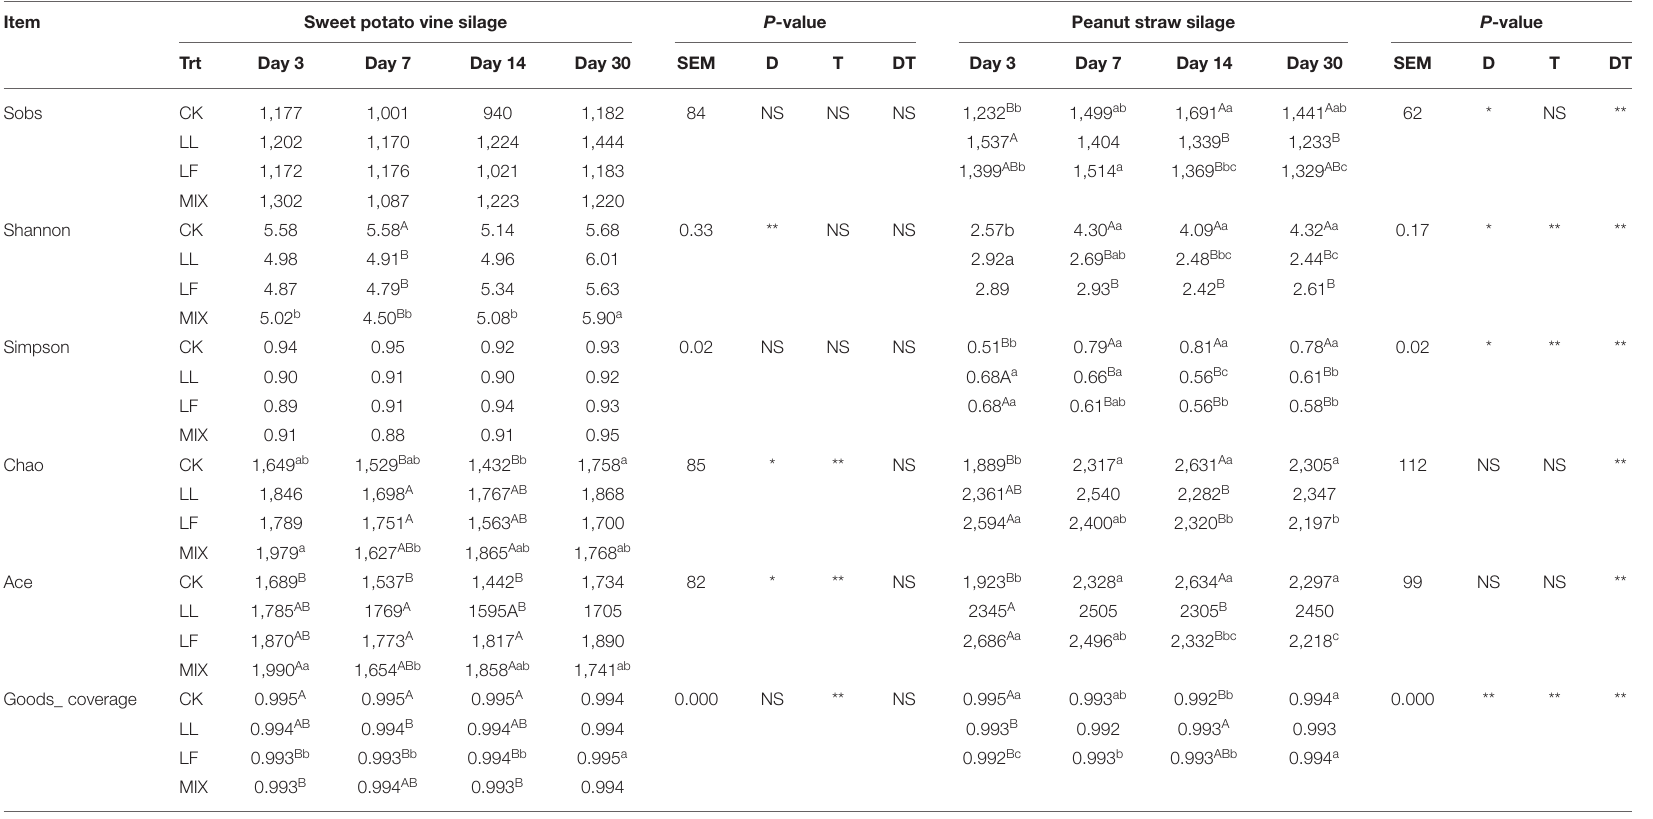
TABLE 4 | The effect of LAB inoculation on the alpha-diversity of bacterial community in SPV and PS silages. Item Sweet potato vine silage Peanut straw silage